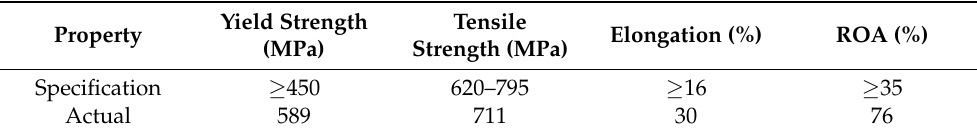
Table 3. Tensile properties of the ferritic steel tube.